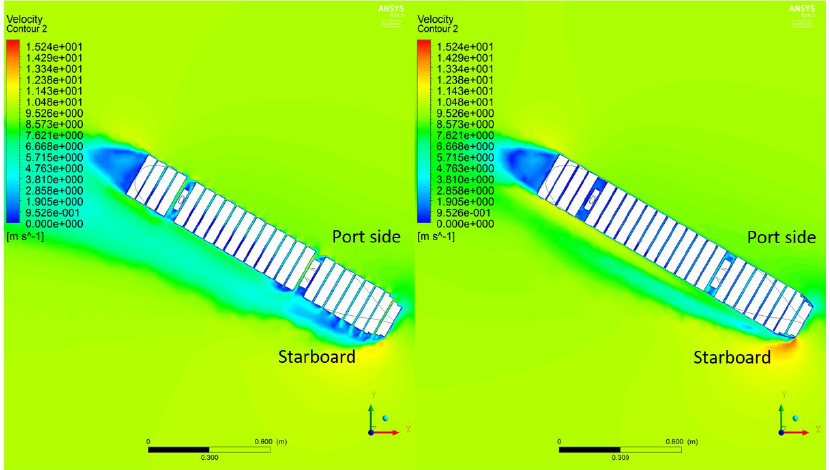
Figure 31. Velocity at z = 0.12 m, ψ = 30 degrees. (Left: without side covers; Right: with side covers).